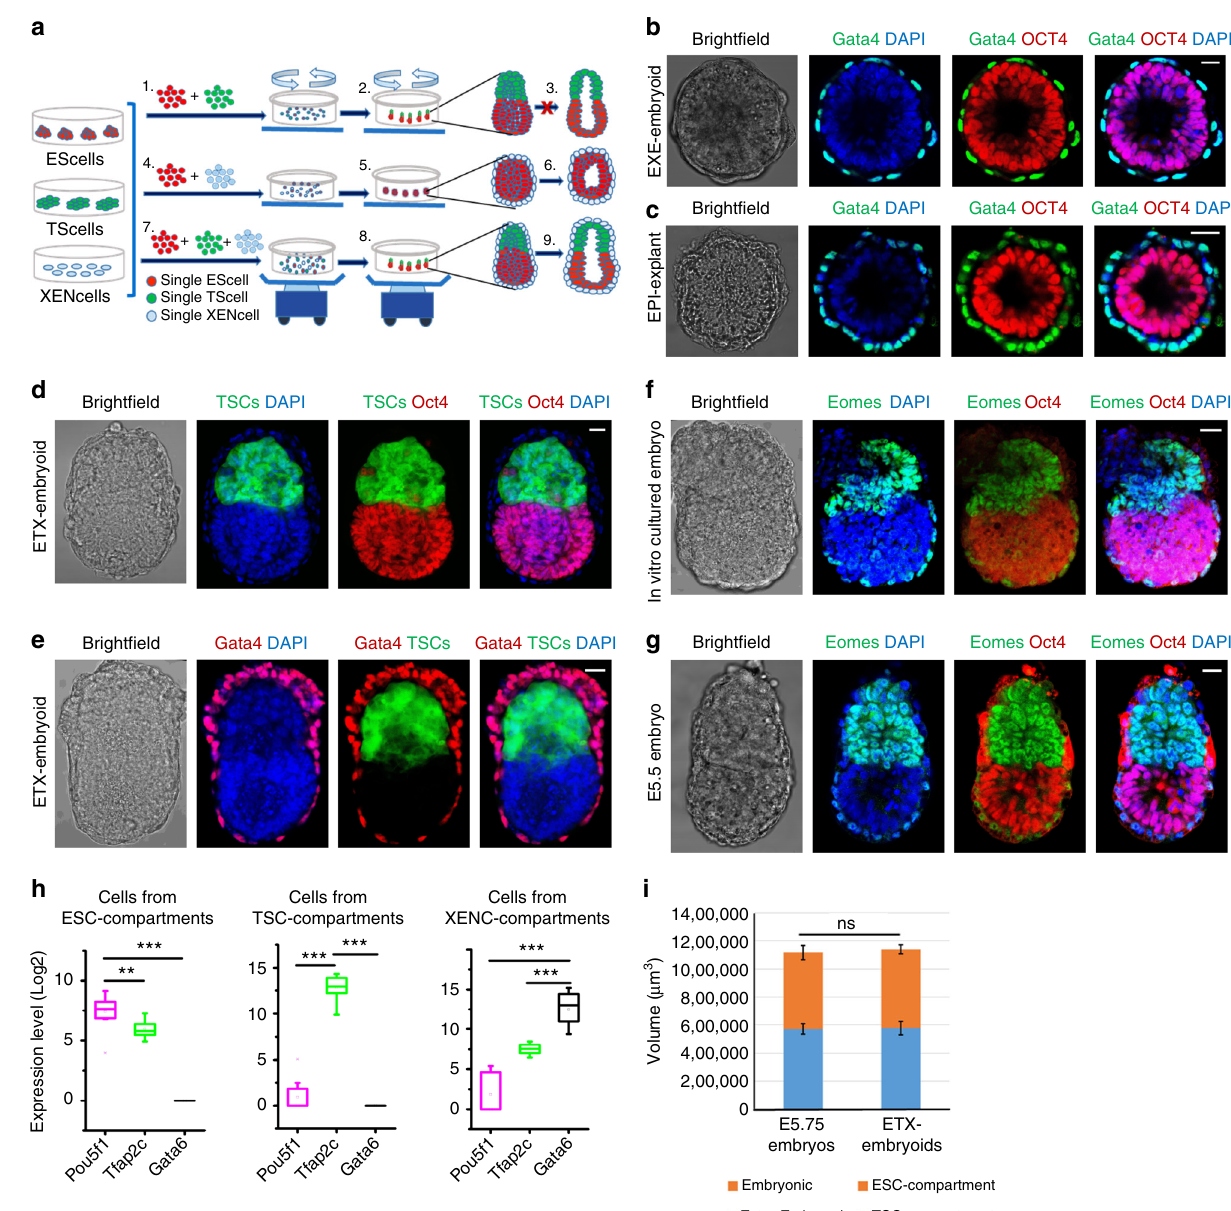
Fig. 1 Self-assembly of different combinations of distinct stem cells into reconstructed embryoids. a Schematic of the protocol to generate self-assembled embryoids. Single-cell populations of ESCs and TSCs were mixed and transferred into a dish containing reconstructed embryo medium on an orbital and horizontal shaker (1), and embryo-like structures (ETS-embryoids) emerged within 24 h (2) but did not undergo lumenogenesis in further culture (3). Similarly, a combination of ESCs and XENCs produced EXE-embryoids within 24 h (4, 5), and these embryoids formed cavities (6). ETX-embryoids were generated within 36 h by combination of the three types of stem cells (7, 8), and these embryos also formed cavities (9). b , c Immunostaining of EXE- embryoids and EPI-explants after culture of 60 and 24 h: DAPI, blue; Gata4, green; and Oct4, red. n = 45 EXE-embryoids; n = 45 EPI-explants. d , e Immunostaining of ETX-embryoids assembled after culture of 72 h from wild-type XENCs and ESCs, EGFP-TSCs: DAPI, blue; TSC-derived tissues, green; Oct4 and Gata4, red. n = 30 ETX-embryoids. f , g Immunostaining of embryos cultured in vitro for 60 h from the E4.5 blastocyst and E5.5 embryos: Oct4, red; Eomes, green; and DAPI, blue. n = 20 embryos. h Box-plots of expression levels of Pou5f1, Tfap2c and Gata6 in cells from ESC-, TSC-, and XENC- compartments, respectively, of the ETX-embryoids. Each cell type is shown in a separate color. The boxed region represents the middle 50% of expression values, the bar in the boxed region indicates the median values, and the whiskers indicate the maximum and minimum values. Cells with outlying expression values are depicted as dots. A background of Ct = 24 was used to obtain expression levels. Two-tailed Student ’ s t -test, n = 11, 11, and 11 single cells from ESC-, TSC-, and XENC-compartments, respectively; ** P < 0.01, *** P < 0.001. i Mean tissue volumes of embryonic and extra-embryonic structures are similar between ETX-embryoids after 84 h and wild-type E5.75 embryos. Two-tailed Student ’ s t -test, n = 34 (ETX-embryoids) and 10 (E5.75 embryos); ns, not signi fi cant, source data are provided as the Source Data fi le. Scale bar, 20 µ m ( b – g ). Columns are means ± s.e.m. Experiments were repeated at least three times ( b – g